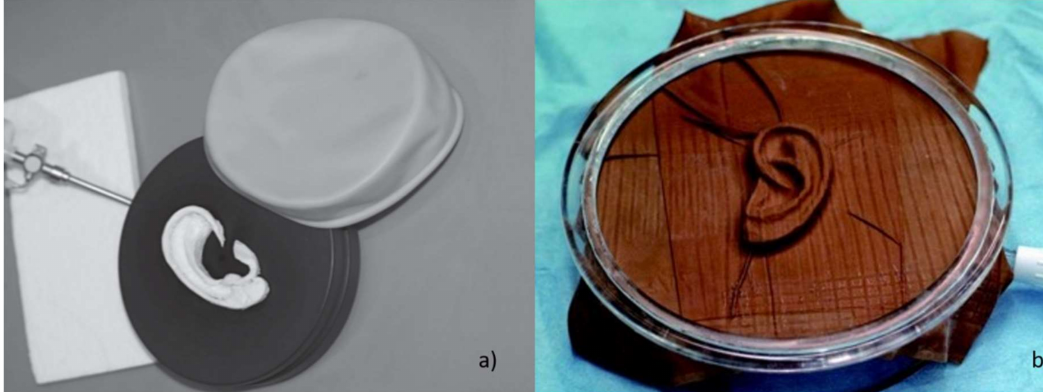
Figure 10. Devices to simulate the skin over the ear framework. ( a ) “Trainer” by Stortz (Tuttlingen, Germany) to simulate the skin over the reconstructed three-dimensional ear framework [28]; ( b ) Similar trainer developed by Oyama et al.